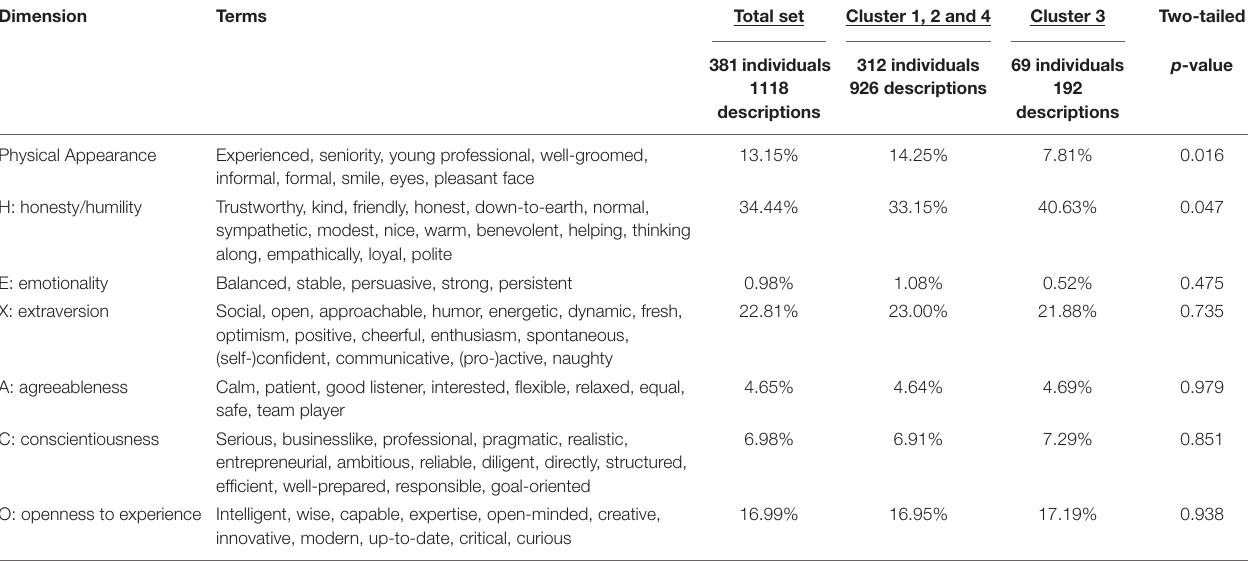
TABLE 5 | Approach motivations: relative distribution of qualitative descriptions, categorized by using the HEXACO-model of personality structure.